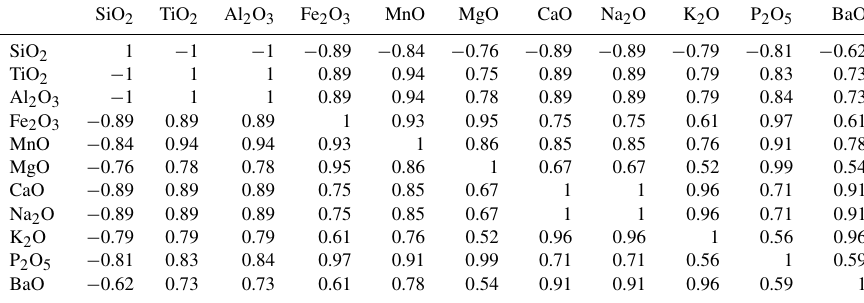
Table A2. Spearman’s coefficients of correlation.